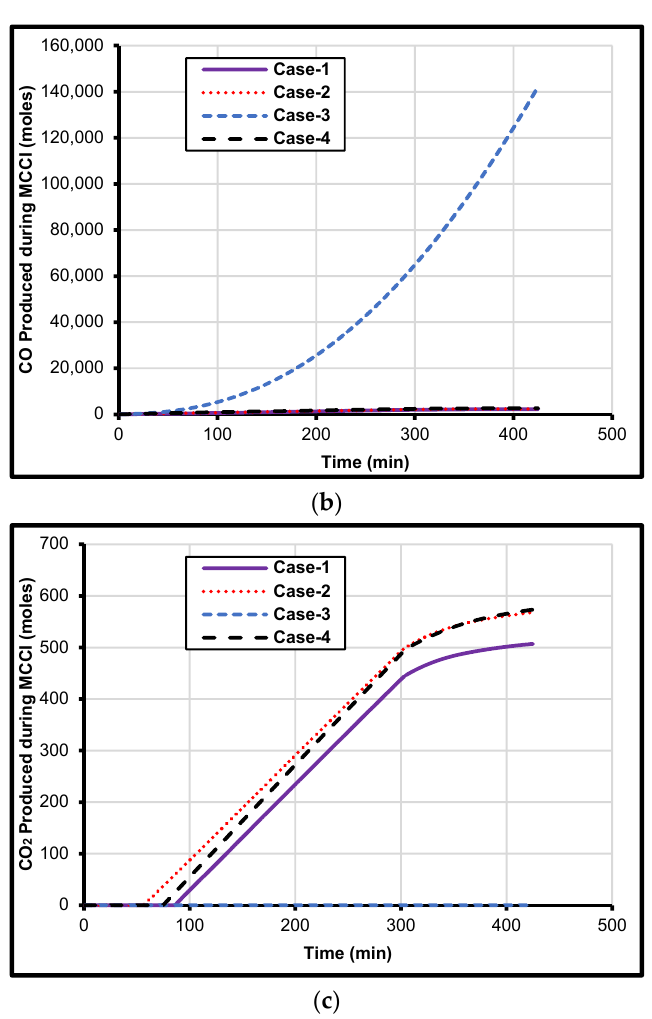
Figure 11. Effect of melt/corium composition during MCCI at 425 min on the production of ( a ) hy- drogen gas, ( b ) carbon monoxide, and ( c ) carbon dioxide